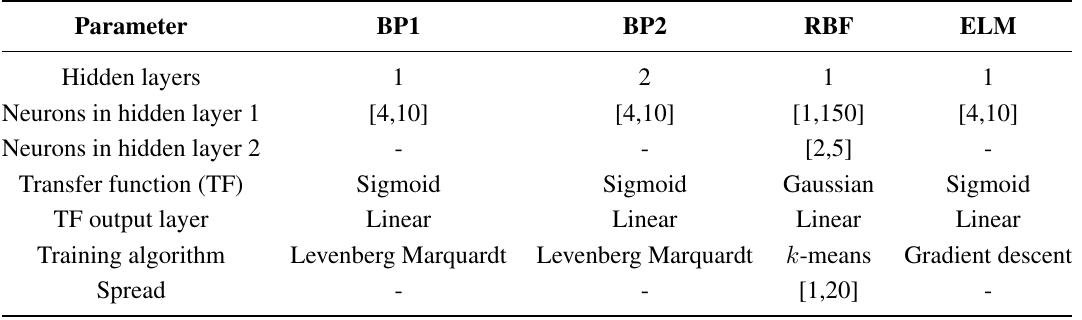
Table 4. Parameters of the network models used. BP: backpropagation; RBF: radial basis function; ELM: Elman neural network.